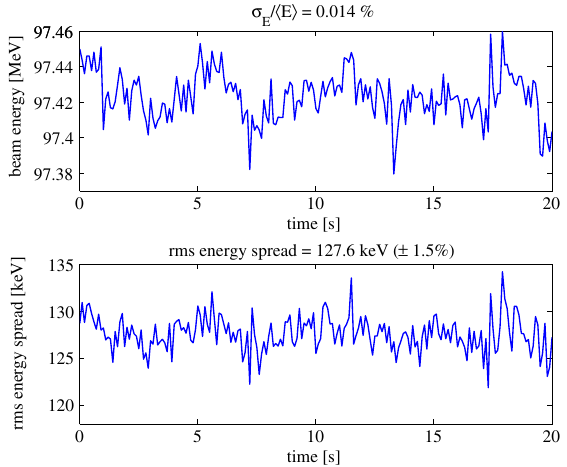
FIG. 7. The bunch mean energy jitter (top) and bunch rms energy spread (bottom) at the injector exit measured over 20 sec at a 10 Hz sample rate.